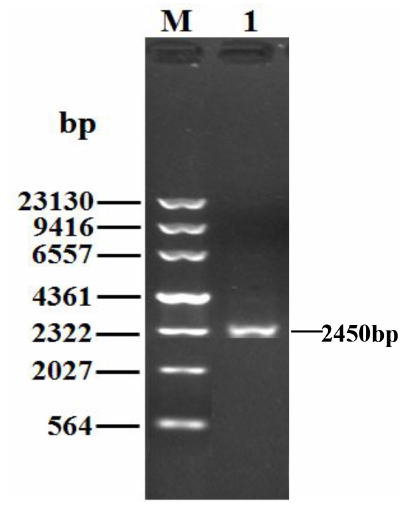
Figure 1. PCR results for the buffalo PPARGC1A gene. M, λ DNA marker; 1, PCR product for the buffalo PPARGC1A